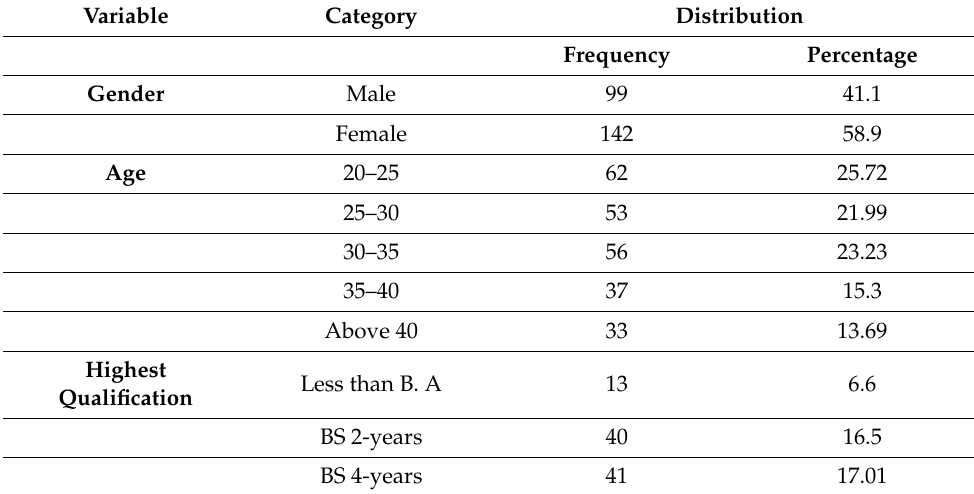
Table 2. Demographic distribution of the